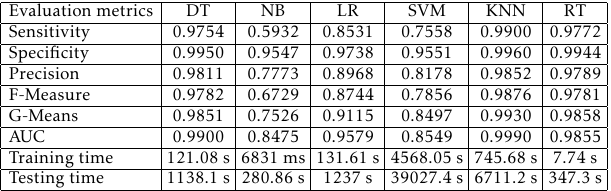
Table 5. Results of using Stacking when classifying DoS on UNSW-NB15 dataset